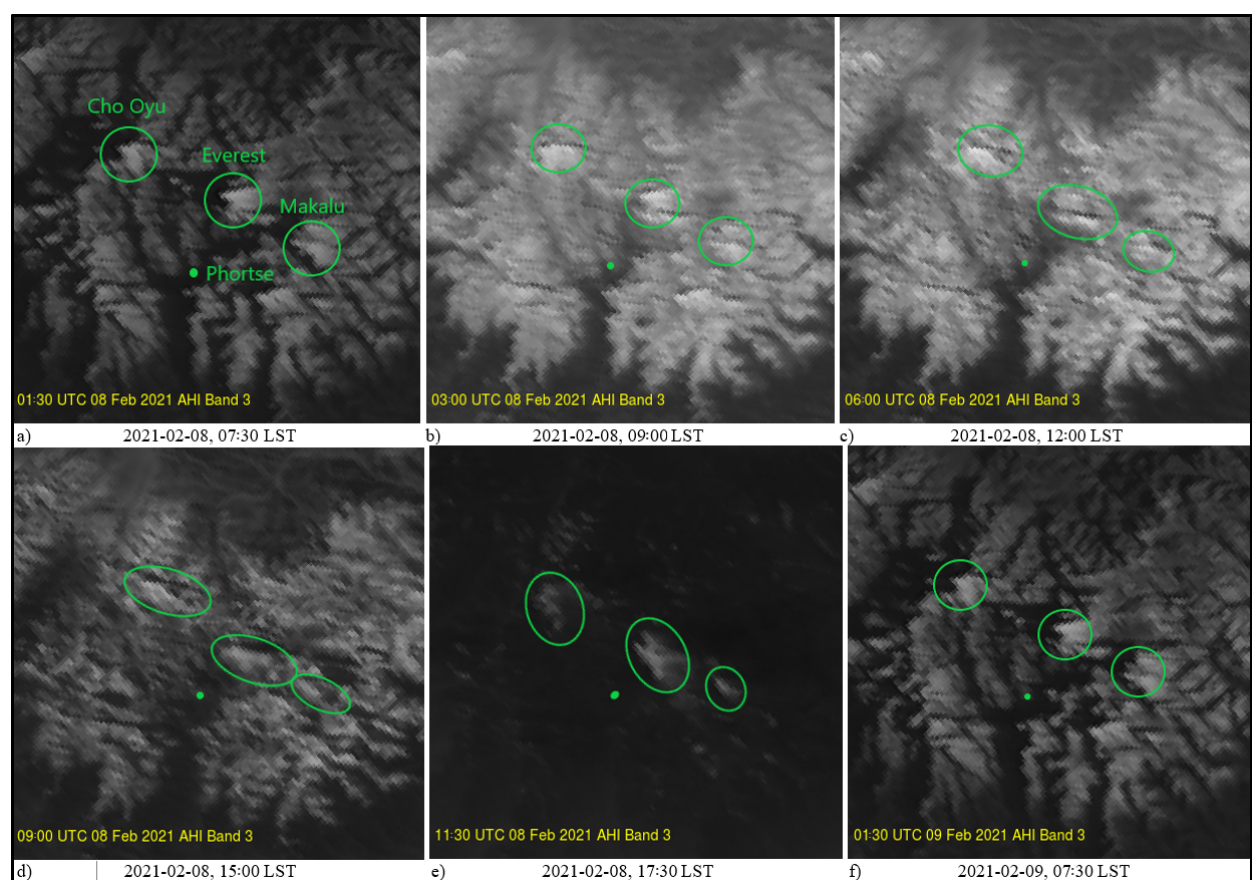
Figure 6. The visible images (a) , (b) , (c) , (d) , and (e) are for 8 February 2021 and (f) is for 9 February 2021 at LST (UTC + 6h). The locations of the major peaks are circled. The corresponding LCL values are listed in Table 1.